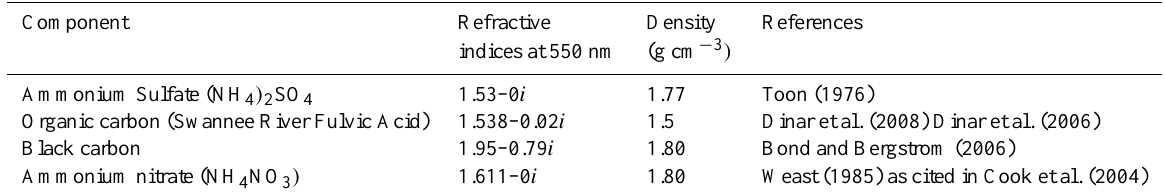
Table 5. Refractive indices and densities used for aerosol components in calculation of mixture density and refractive index for input to Mie